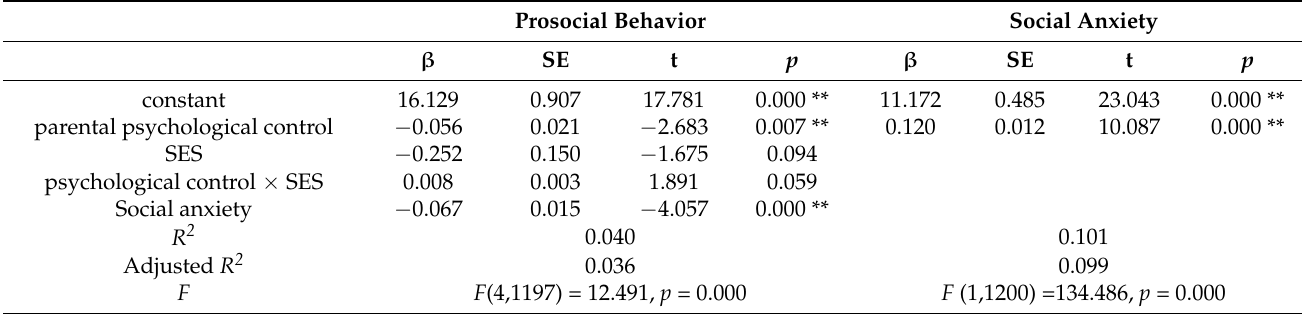
Table 2. Test of moderated mediating effect.